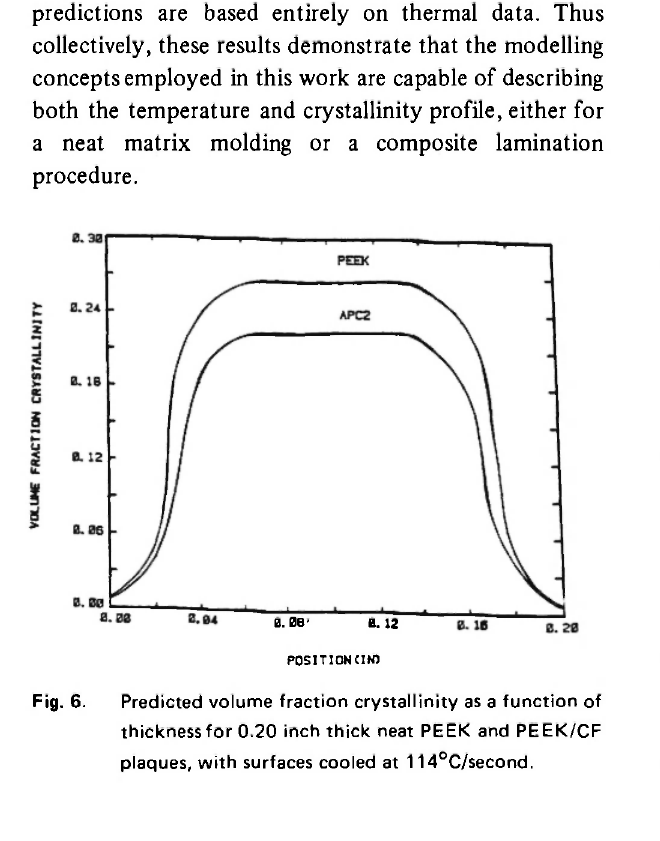
Predicted volume fraction crystallinity as a function of thickness for a 0.16 inch thick neat PEEK plaque, with surfaces cooled at 27.7°C/second. One line represents the prediction obtained using the dual crystallization mechanism model, and the other line represents the prediction obtained using the experi- mental crystallization master curve